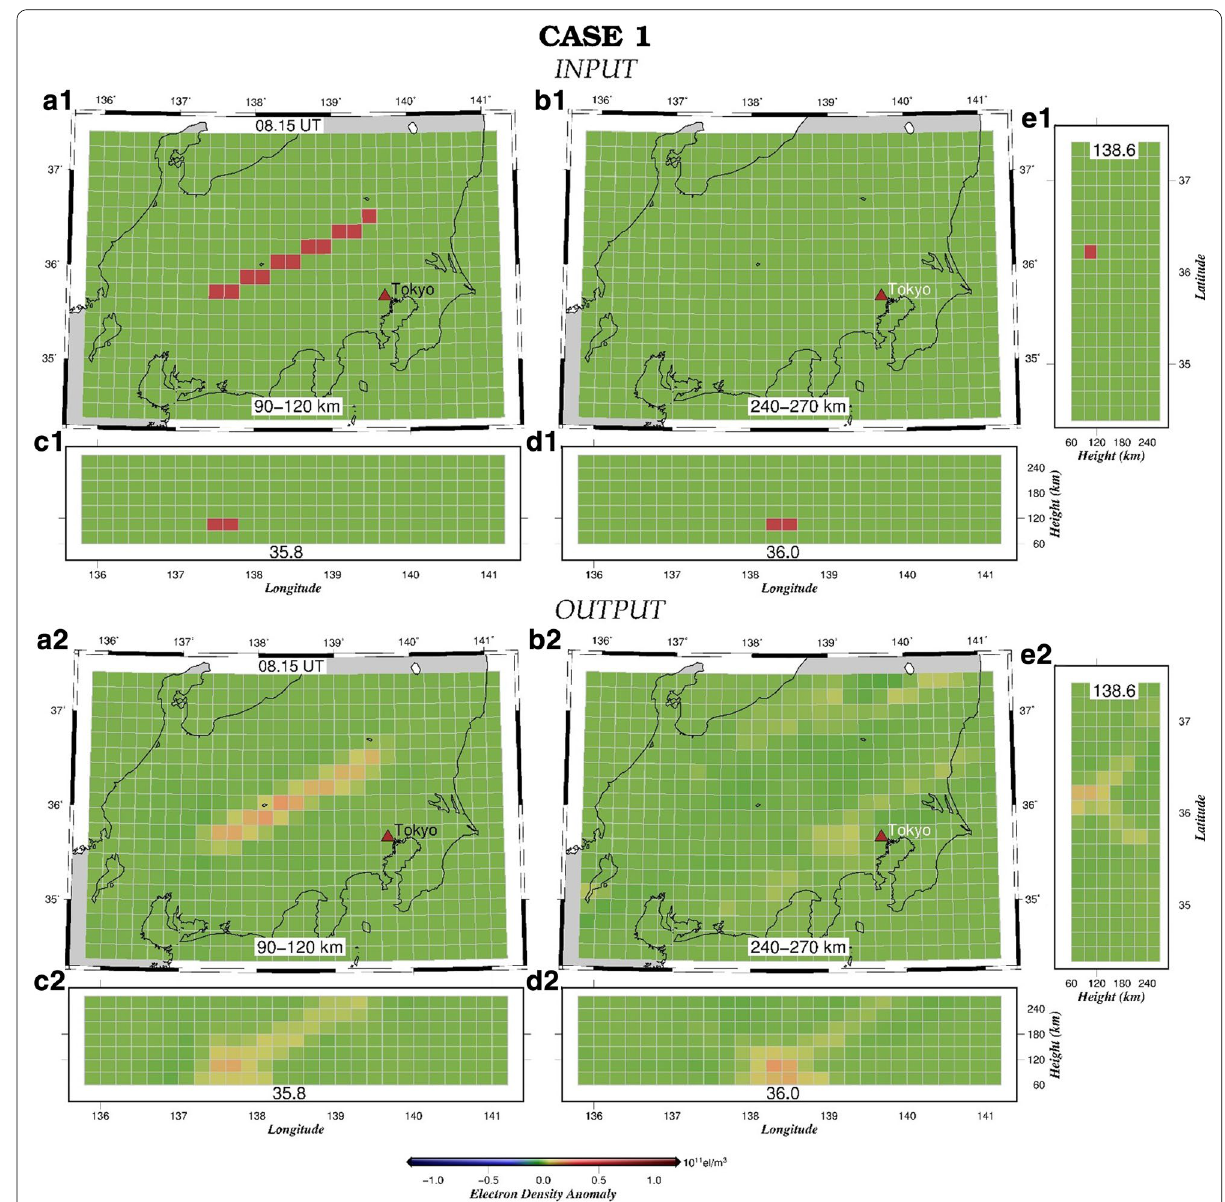
Fig. 4 Recovery test assuming an Es -like electron density anomaly (a block with positive electron density anomaly) at the E region altitude for Case 1. Upper panels show the assumed pattern (input), and the lower panels show the result (output) of the 3D